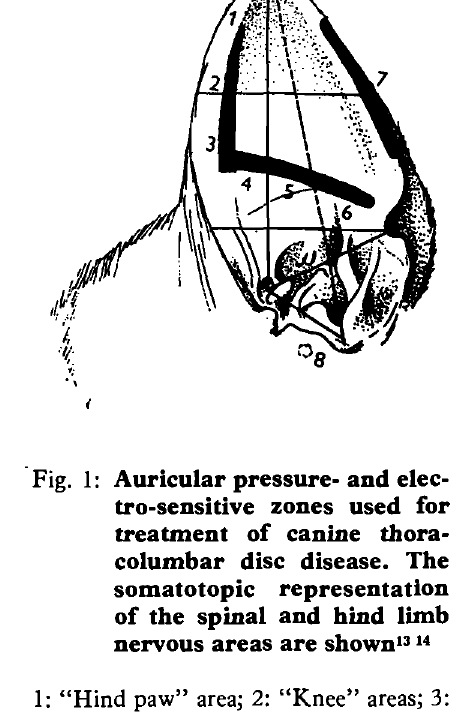
Fig. 1: Auricular pressure- and elec tro-sensitive zones used for treatment of canine thora columbar disc disease. The somatotopic